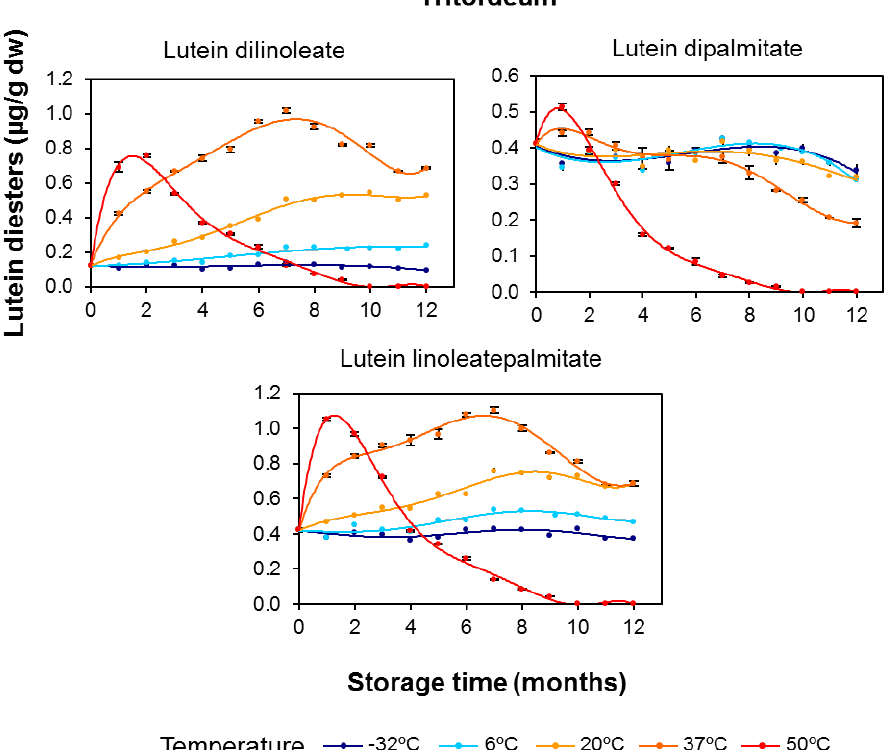
Figure 7. Evolution of the diesterified lutein ( µ g/g dry weight) in tritordeum (HT621 advanced line) whole-grain flours during long-term storage under temperature controlled conditions ( − 32, 6, 20, 37 and 50 ◦ C). The values shown are the mean and standard error ( n = 5 for the starting sample, n = 3 for the rest of the samples).